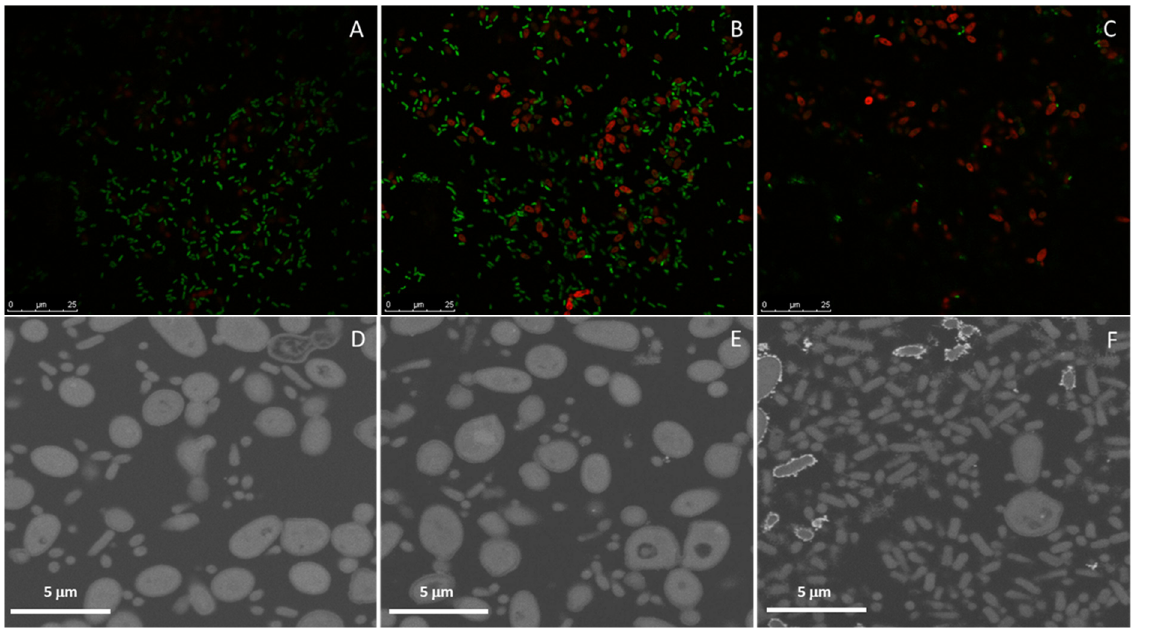
Figure 5. Dual biofilms of E. cloacae complex ( E. bugandensis ) and C. parapsilosis assembled on glass and polyurethane. Biofilms assembled on glass were monitored using FISH with the bottom ( A ), intermediate ( B ) and top layers ( C ) shown with E. cloacae complex ( E. bugandensis ) (green) and C. parapsilosis (red). Biofilms assembled within the polyurethane CVC lumen were monitored using FIB SEM with the bottom, intermediate and top layers shown in ( D , E , F ), respectively.